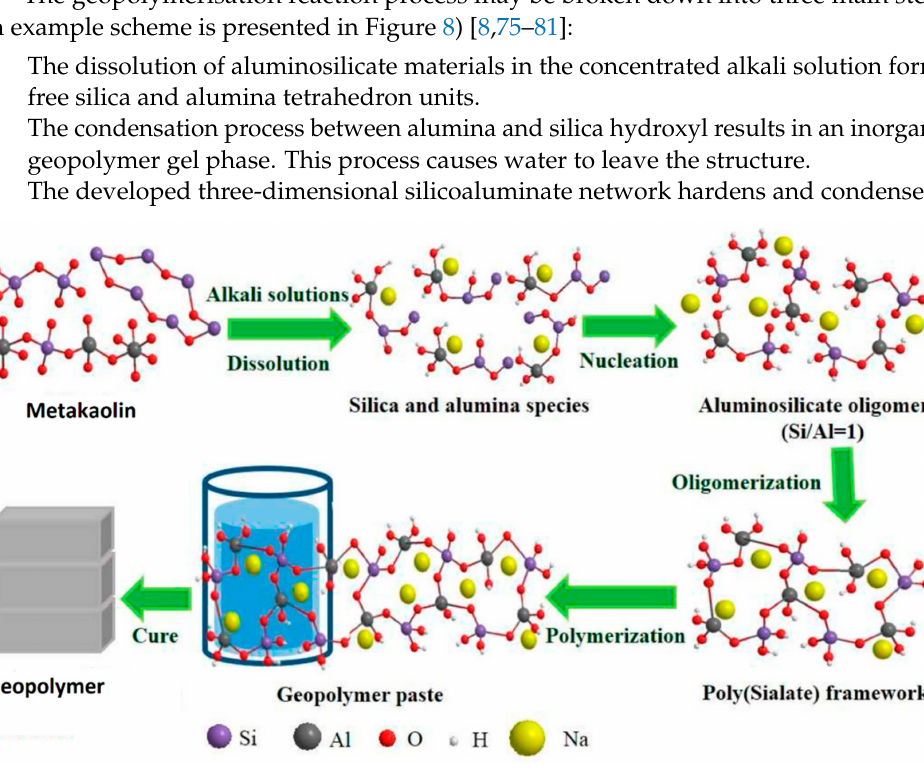
Figure 8. Reaction mechanism of a metakaolin-based geopolymer material